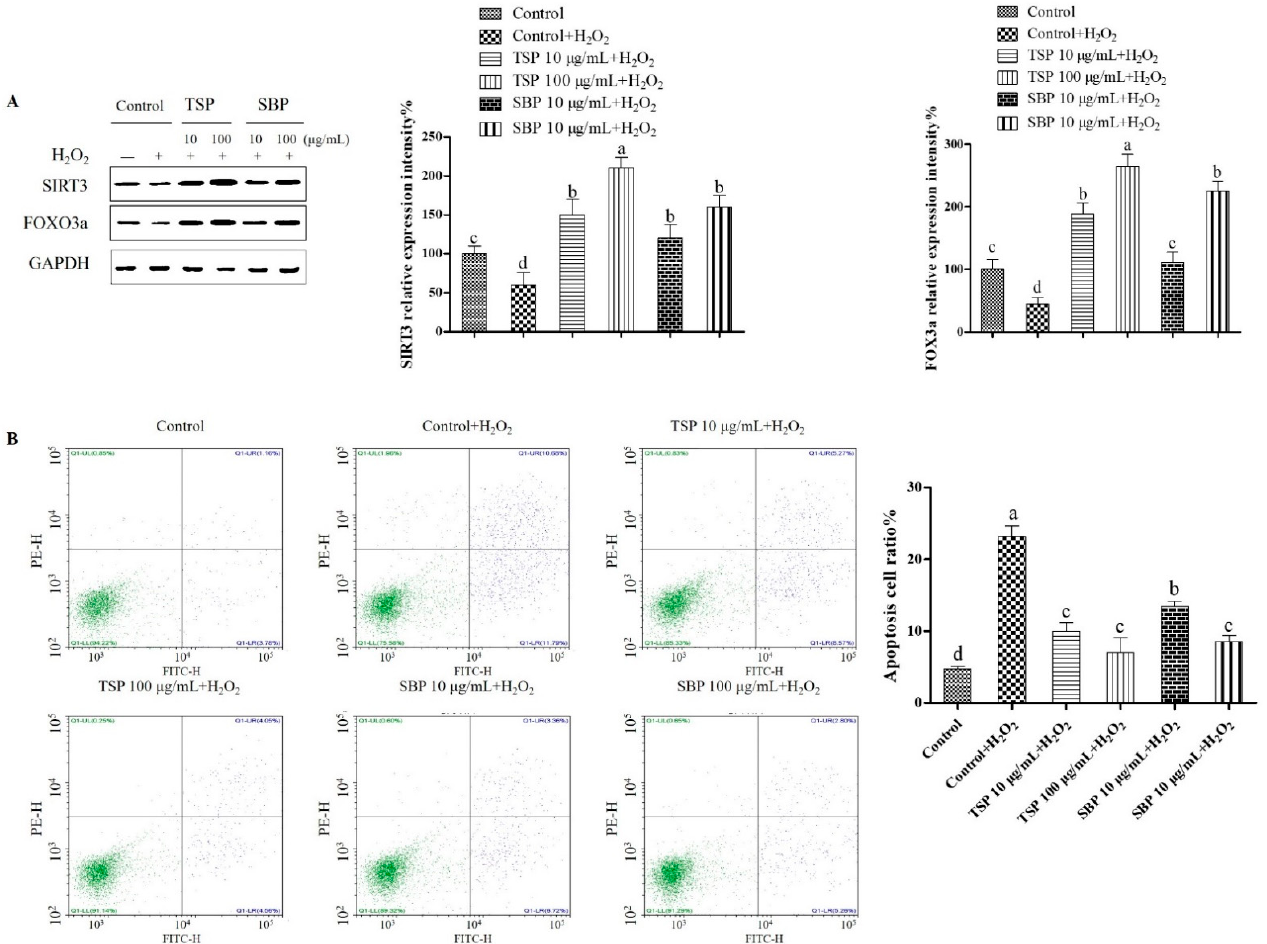
Figure 4. Prevention of mitochondria-mediated apoptosis and oxidative damage through the SIRT3- FOXO3a signaling pathway by SBP and TSP followed with cell incubation for 48 h and finally exposure to 250 µ M H 2 O 2 . ( A ) SBP or TSP effect on SIRT3 and FOXO3a protein expression. ( B ) PC-12 cells’ mitochondria-dependent apoptosis induced by H 2 O 2 in SBP and TSP attenuated manner. Data are expressed as the means ± SD ( n = 3), results marked with different letters (a, b, c and d) are significantly different ( p < 0.05).